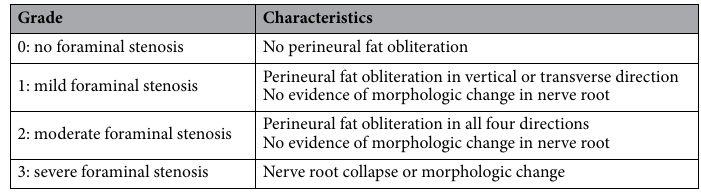
Table 1. Classification of lumbar foraminal stenosis as proposed by Lee et al. 6